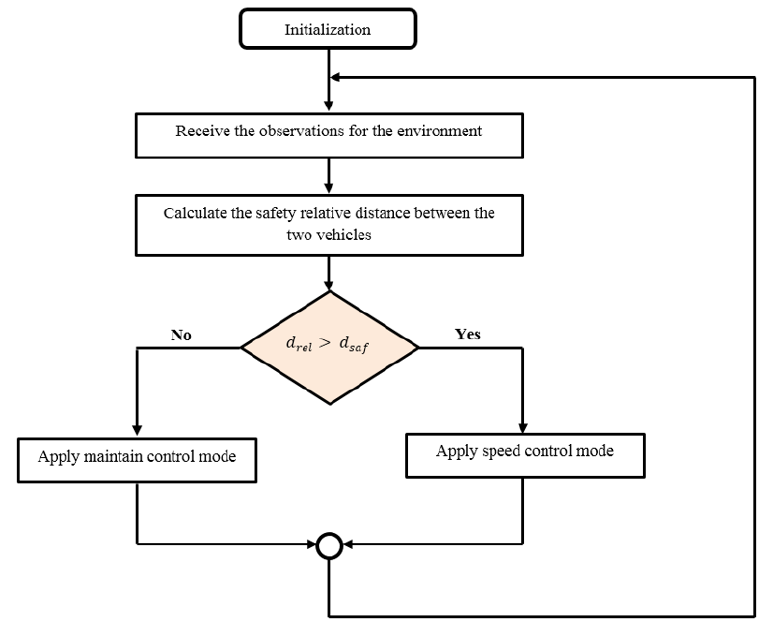
Figure 6. The schema of applying the control